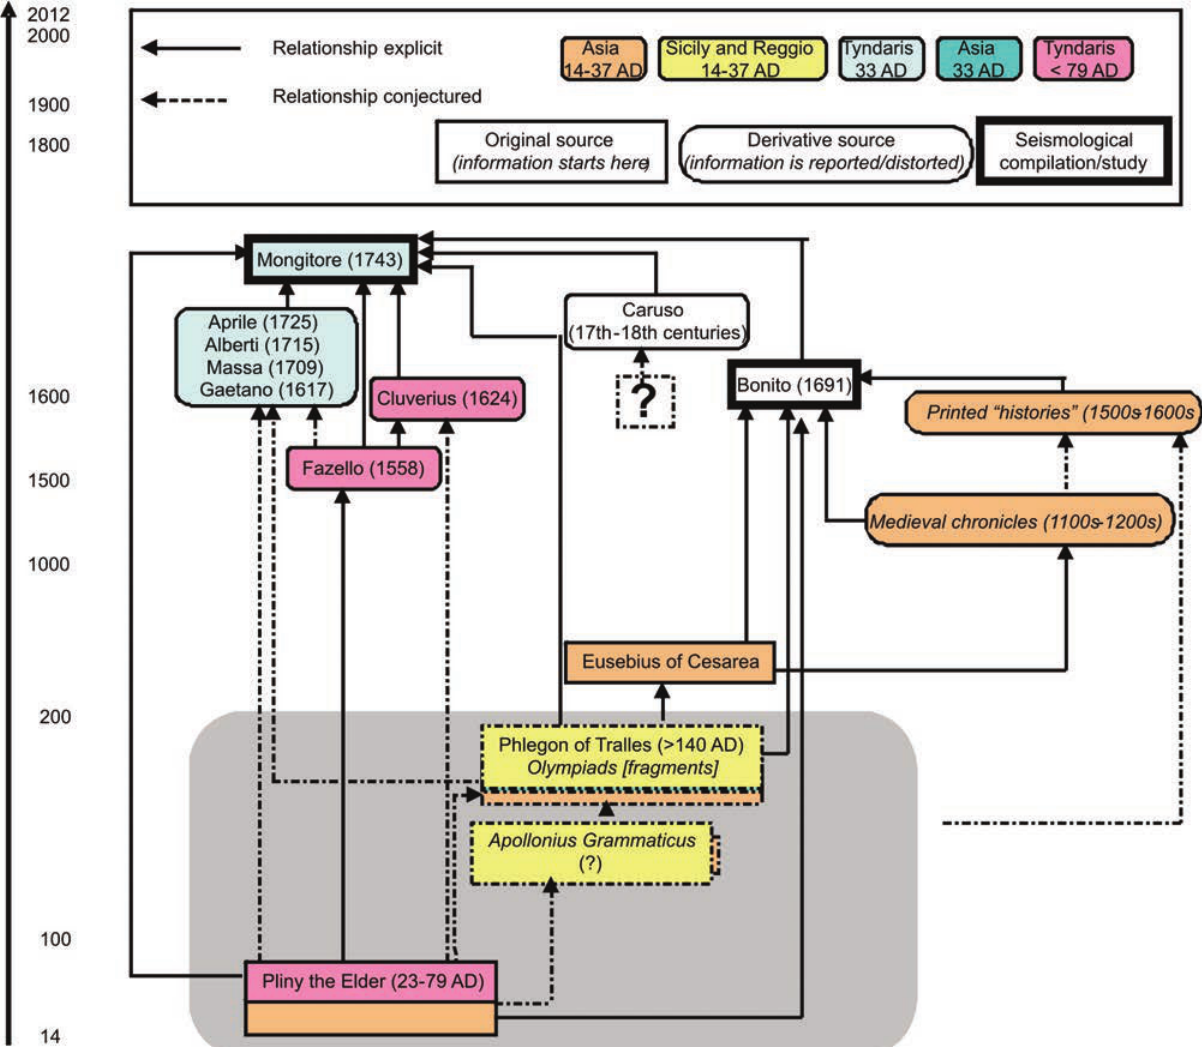
Figure 4. Flow chart of studies and sources revaluated in this study for the 1st century earthquake. Note that the Guidoboni ed. [1989] cat- alogue was based upon Bonito [1691] and a chronicle [Phlegon of Tralles 2nd century], whereas Mongitore [1743] used Sicilian local his- tories based on Pliny the Elder [1st century], as